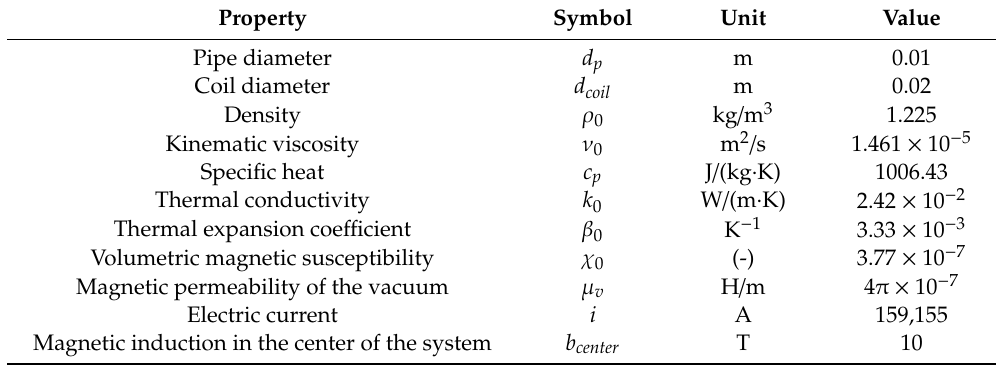
Table 1. Exemplary dimensional system and fluid properties for Pr = 0.7 (air) and Ri m = 5.